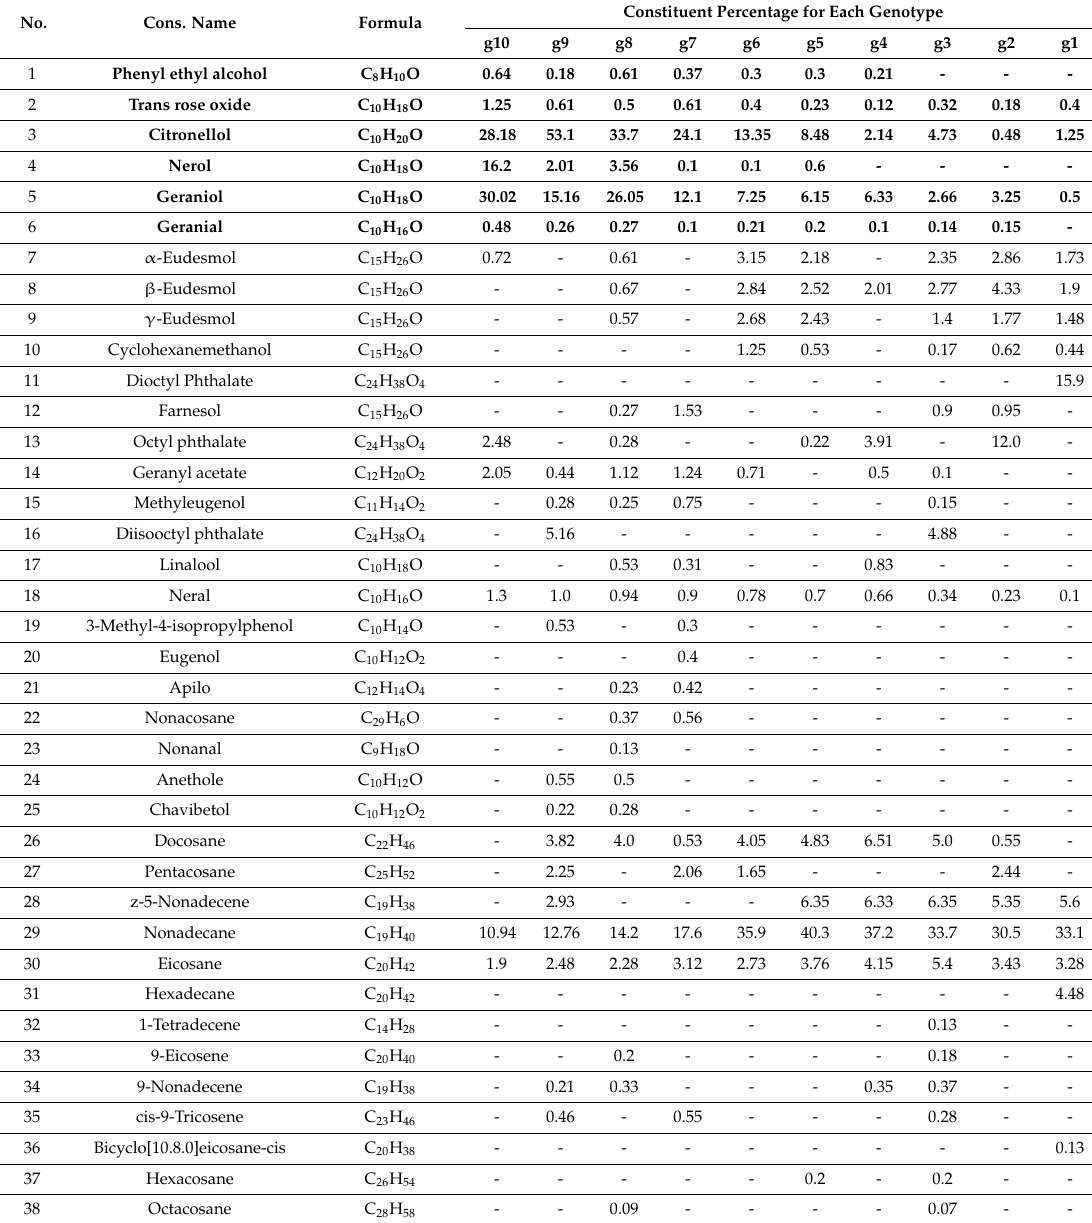
Table 3. Chemical constituents of Iranian Rosa essential oils determined by GC-MS